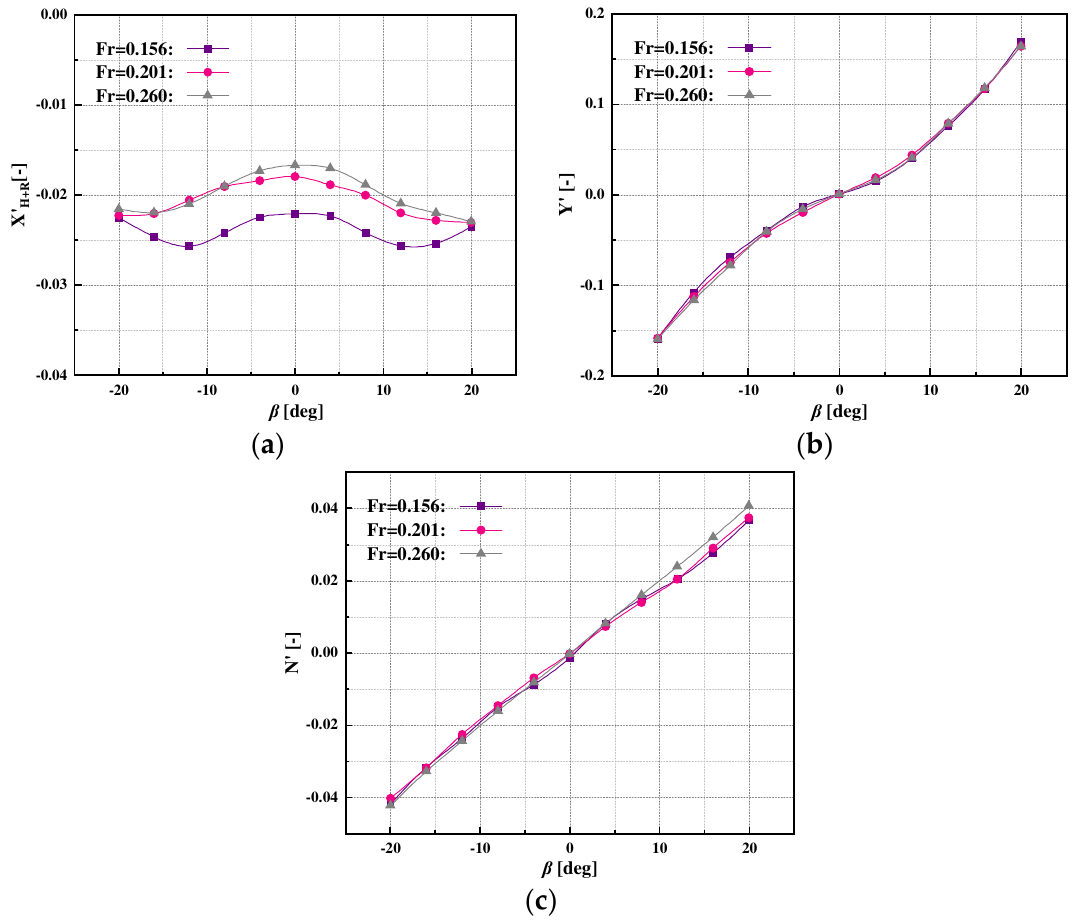
' N . Figure 4. CFD (water–air flow) results for static drift motion. ( a ): X